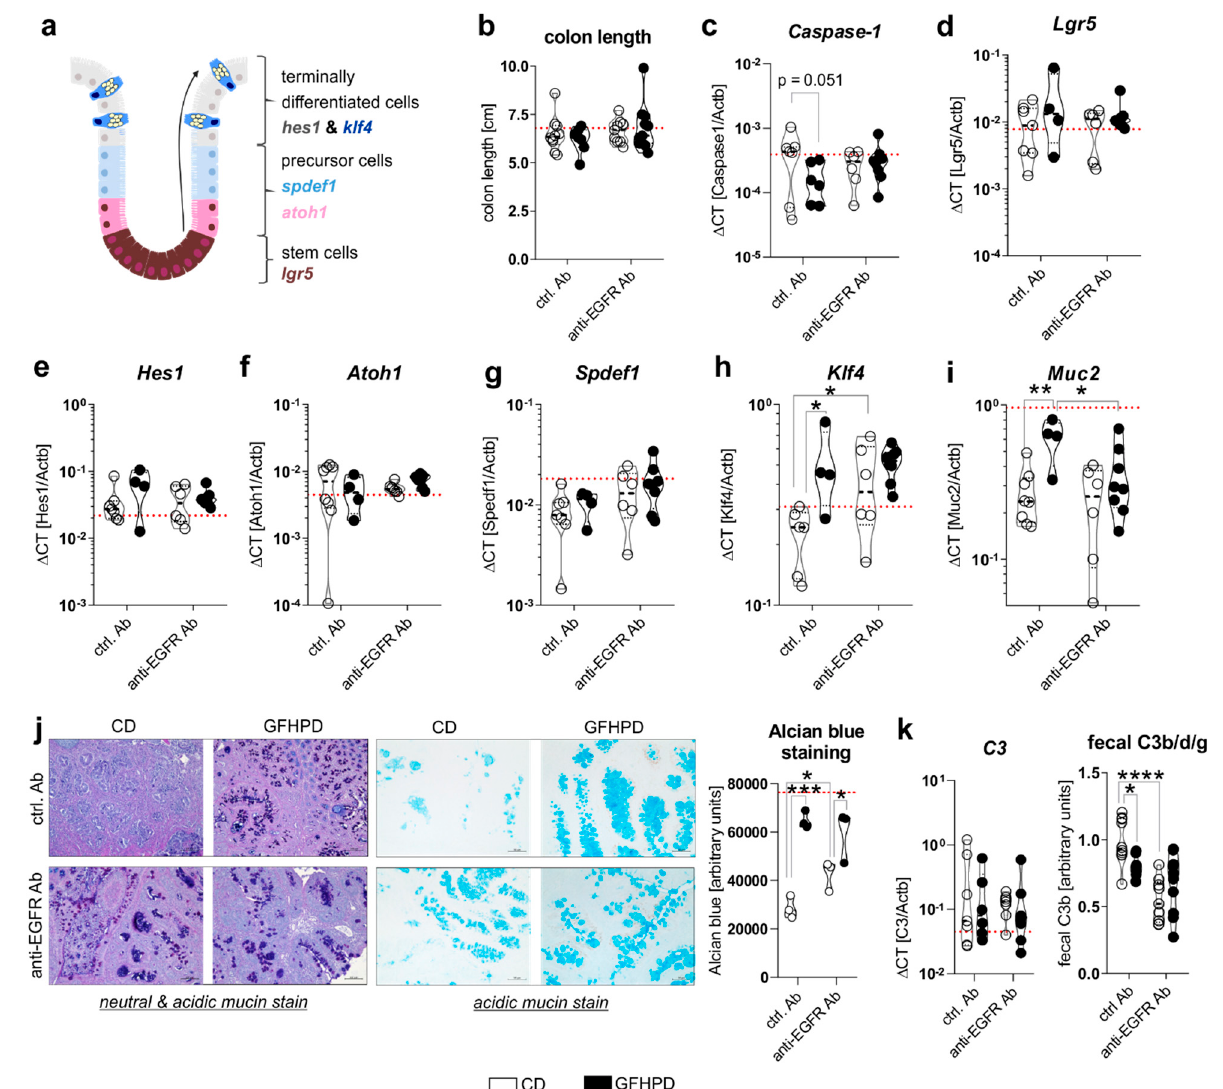
Figure 4. GFHPD consumption is accompanied by increased goblet cell differentiation of CRC tumors to a similar extent compared to anti-EGFR Ab therapy. ( a ) A model for intestinal epithelial cell differentiation in the colonic crypt. ( b ) Whole colon length was determined at day 126. ( c – i ) mRNA expression levels of ( c ) Caspase-1 , ( d ) Lgr5 , ( e ) Hes1 , ( f ) Atoh1 , ( g ) Spdef1 , ( h ) Klf4 , or ( i ) Muc2 were quantified by qPCR in colonic biopsy samples collected from indicated treatment groups. Ctrl. Ab ( n = 6–8 CD; n = 4–6 GFHPD), anti-EGFR Ab ( n = 6–7 CD; n = 8–9 GFHPD). ( j ) Representative histochemical PAS/Alcian (left panel) or Alcian blue (right panel) staining of PFA-fixed, paraffin-embedded tumor tissue biopsies from indicated treatment groups. Original magnification, 10×. ( k ) Colonic C3 mRNA expression was quantified by qPCR experiments (left panel). Ctrl. Ab ( n = 7 CD; n = 6 GFHPD), anti-EGFR Ab ( n = 7 CD; n = 8 GFHPD). Fecal C3b/d/g protein levels were measured by Western blot experiments utilizing fecal samples collected from indicated treatment groups of AOM/DSS mice (right panel). Densitometric analysis was performed using the ImageJ software. Ctrl. Ab ( n = 10 CD; n = 7 GFHPD), anti-EGFR Ab ( n = 9 CD; n = 10 GFHPD). Red dotted horizontal lines represent respective median values of PBS-treated control mice at day 126. * p ≤ 0.05, ** p ≤ 0.01, *** p ≤ 0.001, **** p ≤ 0.0001.